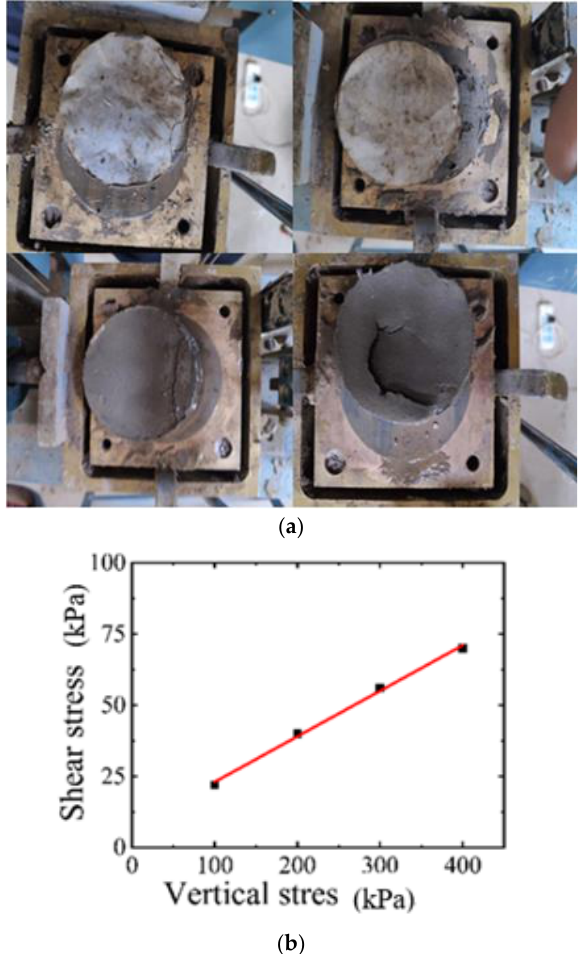
Figure 2. Soil test picture. (a) The shear strength curve; and (b) The shear strength curve. The grain composition of soil samples was determined by sieve analysis and hy- drometer (d < 0.075 mm). The results are shown in Table 1 and Figure 3. Table 1. Soil particle composition.